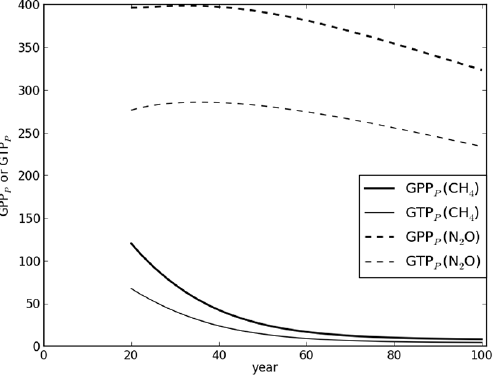
Figure 4. GPP P (in bold) and GTP P for 1kg pulse emissions of N 2 O and CH 4 relative to a 1kg pulse emission of CO 2